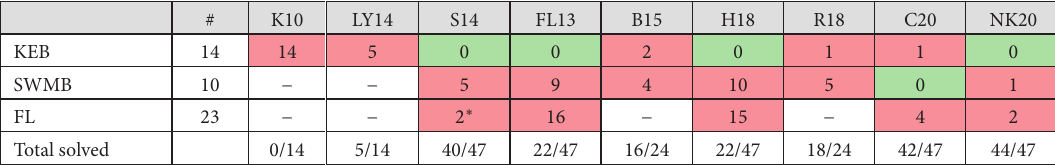
Figure 4: The pseudocode of the PEASTP metaheuristic. Table 4: The summary of the nine solution